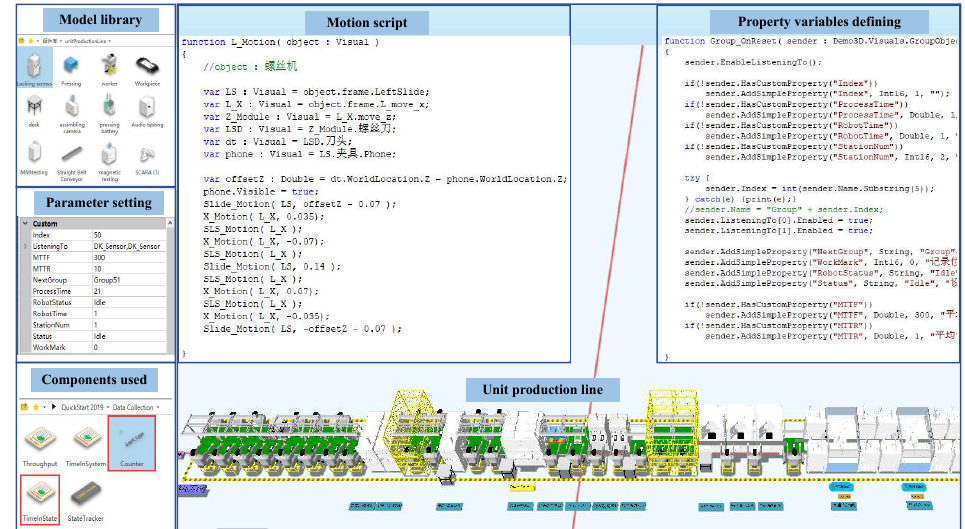
Figure 6. The construction steps of the semi-physical simulation